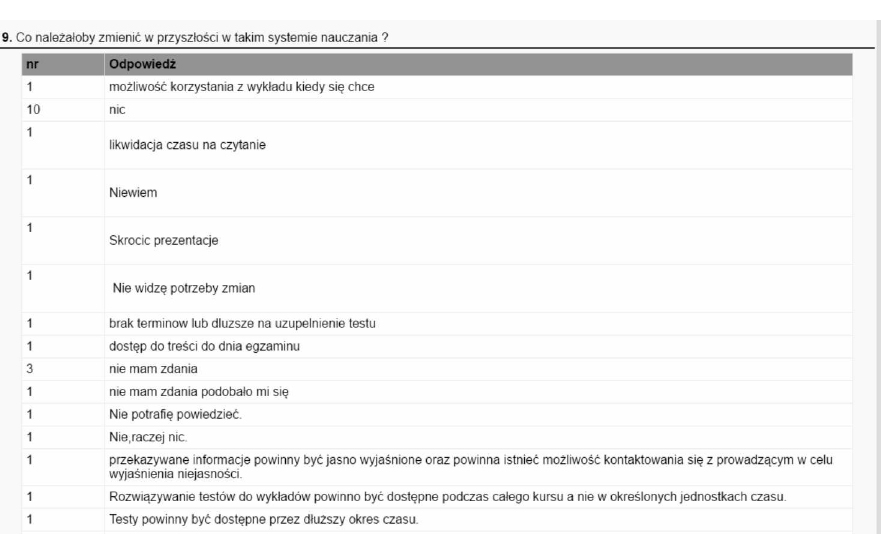
Figure 8. Examples of students’ responses to the question: “What should be changed in such a system of learning in the